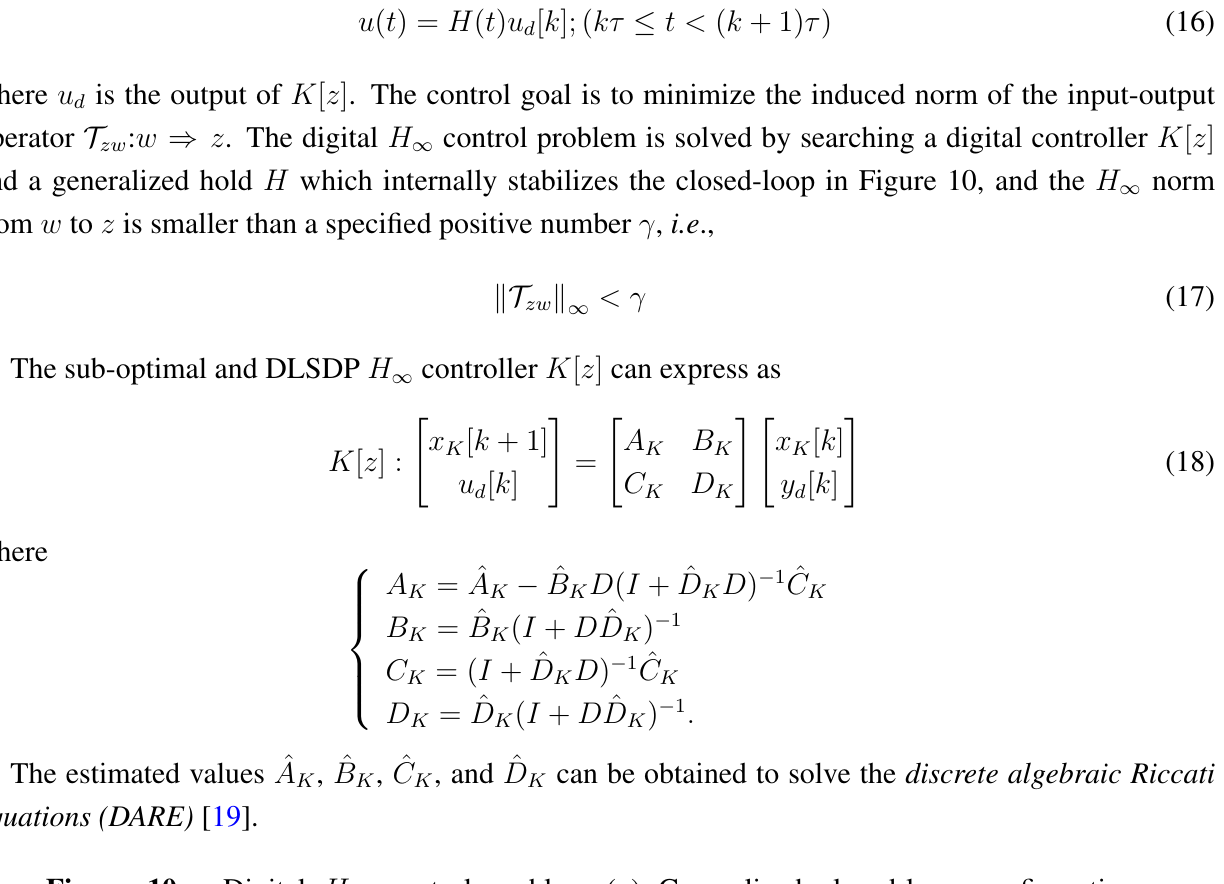
Digital H control problem ( a ) Generalized closed-loop configuration; ∞ ( b ) Feedback